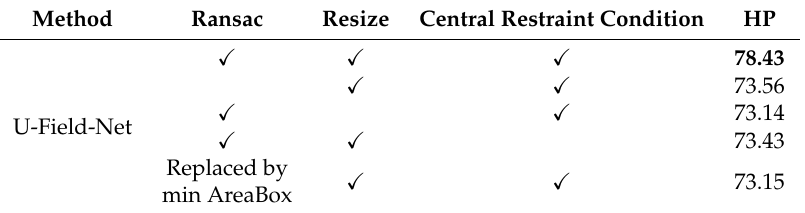
Table 2. Results of ablation Algorithm (RFA) on the DOTA dataset at the training. Ransac means whether to use the ransac method when calculating ellipse parameters. Resize indicates whether the output field is enlarged by 2 times. Central restraint condition means whether to consider the central constraint by Equation (12).